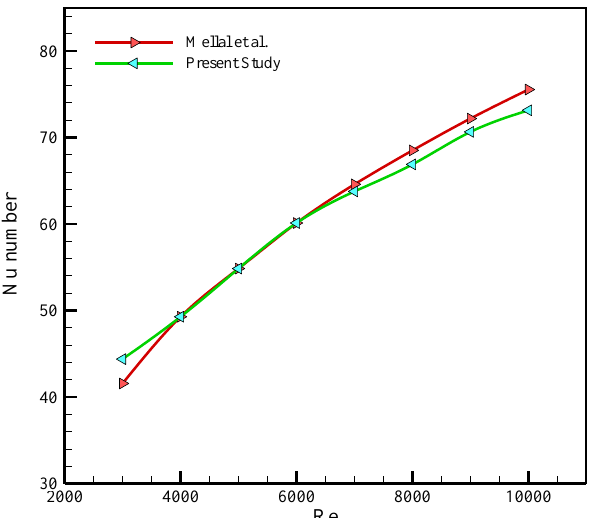
Figure 3. Comparison of Nusselt number of the present study and Mellal et al. [42].